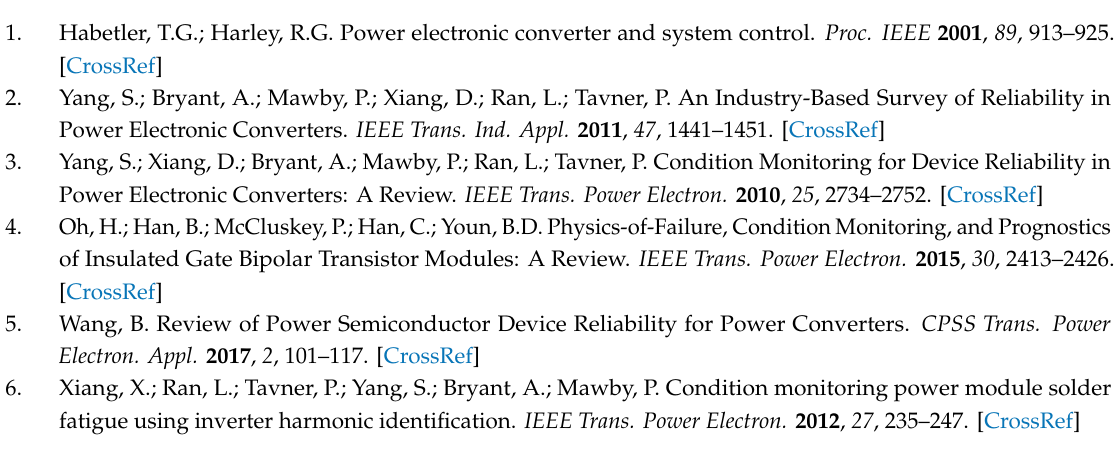
Figure 12. T on and T off with different I C .